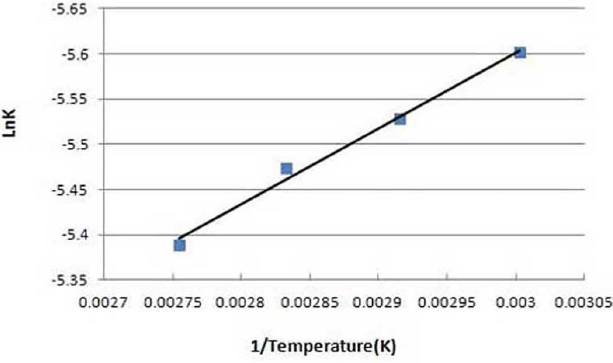
FIGURE 5 - Arrhenius plot of HCTZ-lactose liquid mixture at pH=7.1. TABLE II - Kinetic parameters of HCTZ-lactose liquid mixture interaction at pH=13.1 and 7.1 obtained by conventional isothermal Arrhenius method